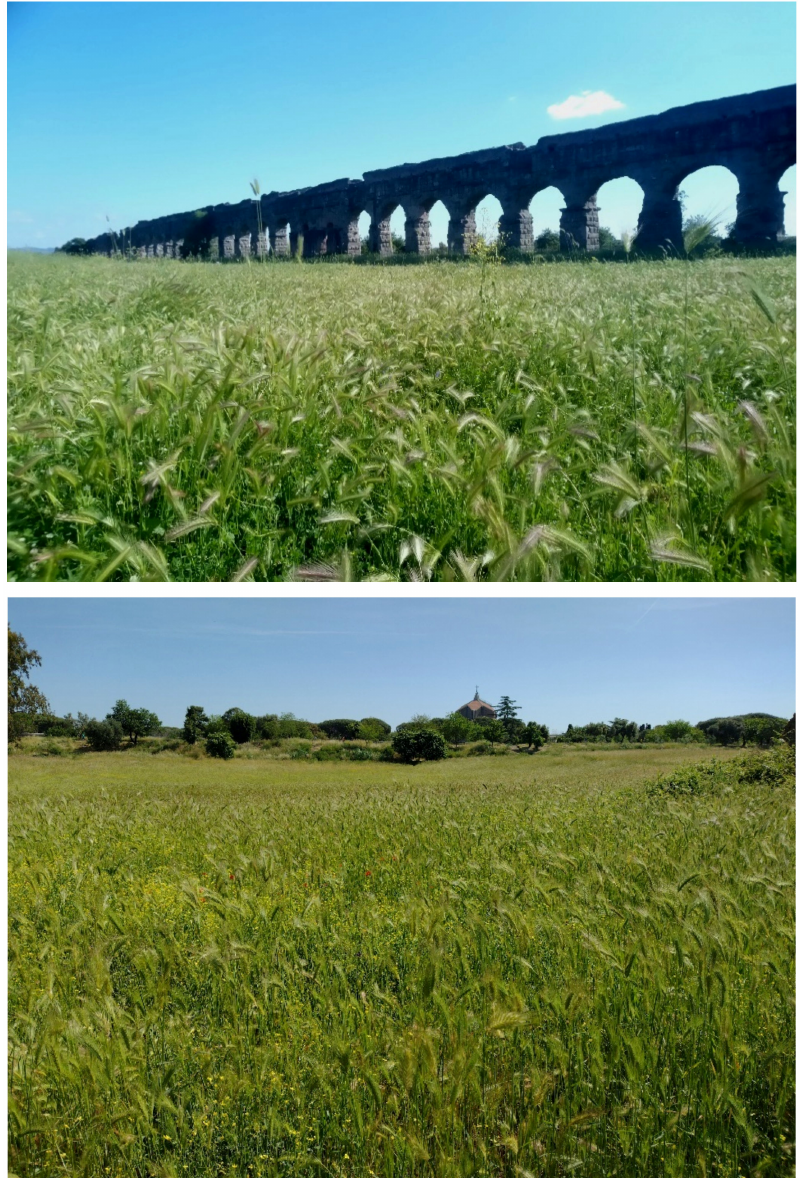
Figure 33. Chenopodietea: Hordeion-murini (Acquedotty locality; top photo); Securigero securidacae- Dasypyrion villosi (Acquedotti locality; bottom